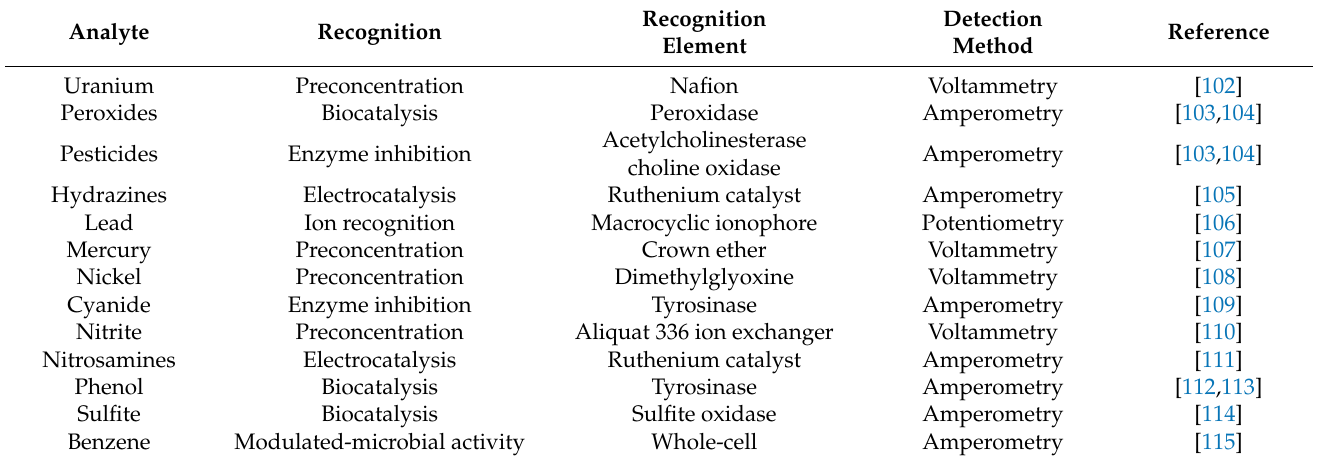
Table 4. Environmental analyses using electrochemical sensors and